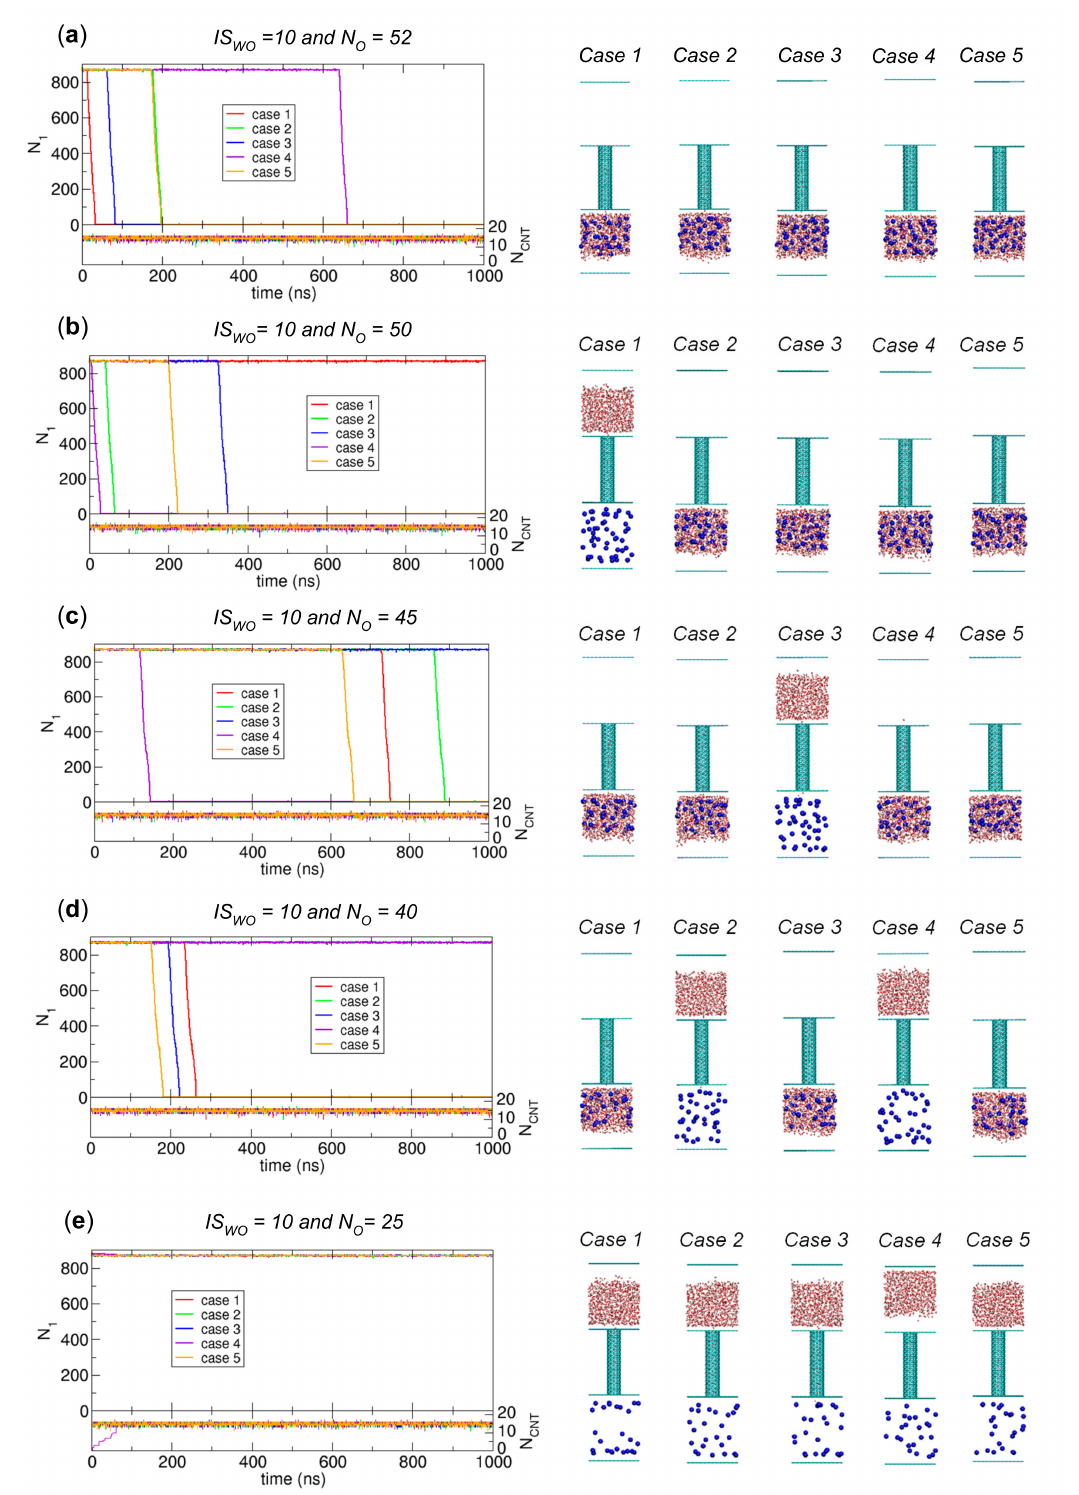
Figure 10. Results of 1000 ns simulations for the systems of N O = ( a ) 52, ( b ) 50, ( c ) 45, ( d ) 40, and ( e ) 25 with IS WO = 10. For each system, we perform five independent simulations, and we plot the numbers of water molecules in Compartment 1 ( N 1 ) and the CNT ( N CNT ) as functions of time (left) along with the final configurations at 1000 ns from the five simulations